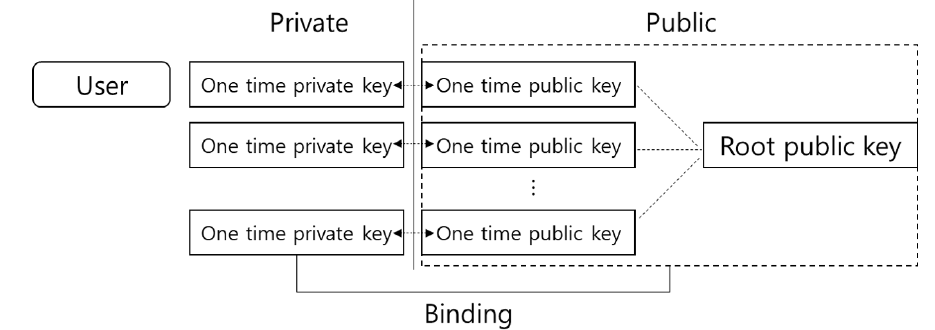
Figure 3. One-time keys and root